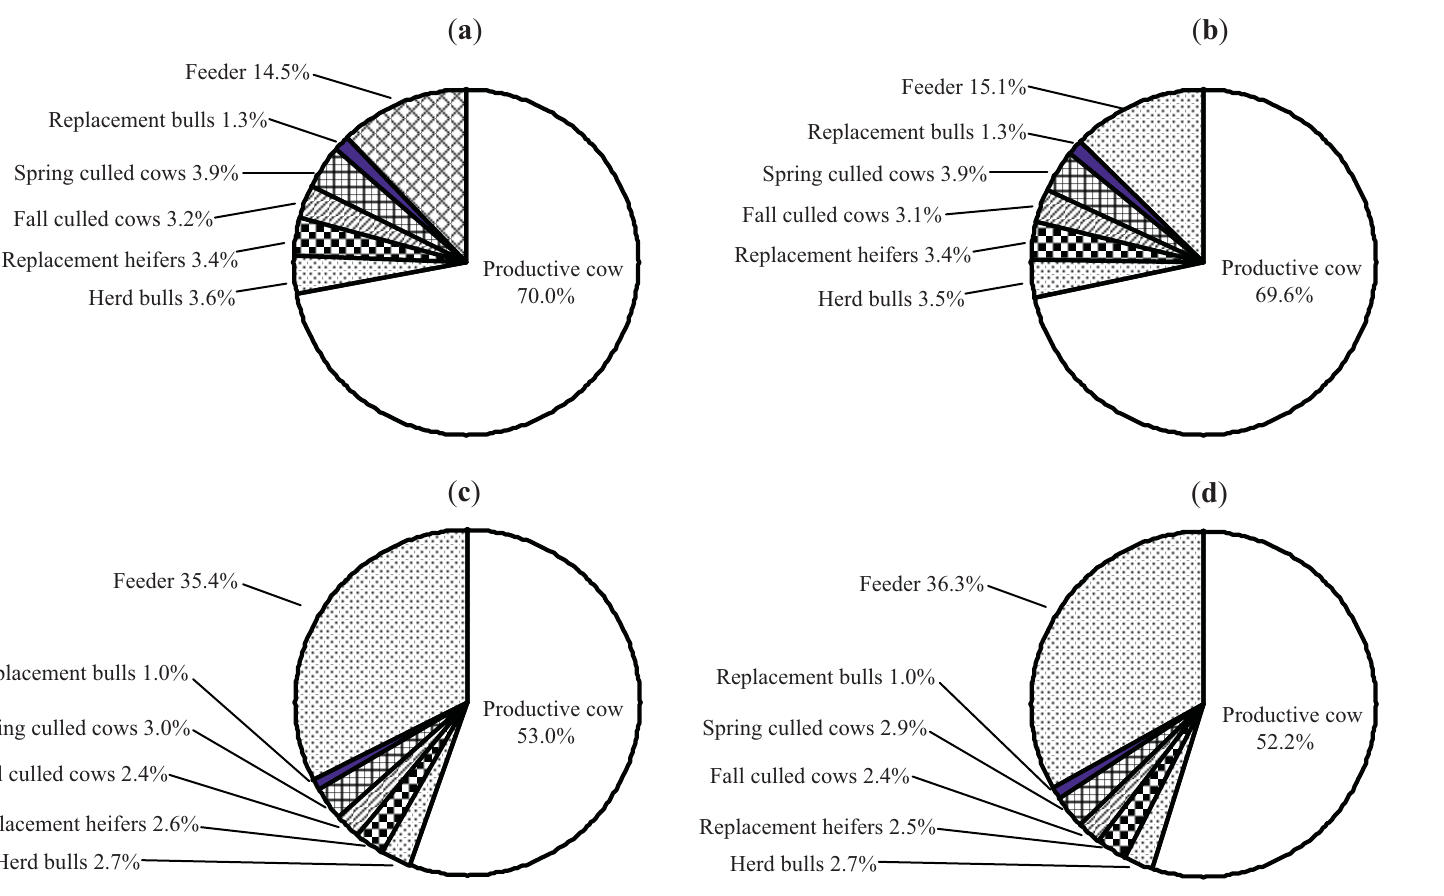
e. 2 e. ( c ) Yearling-fed, Hormone Free Animal GHG emissios = 2 2